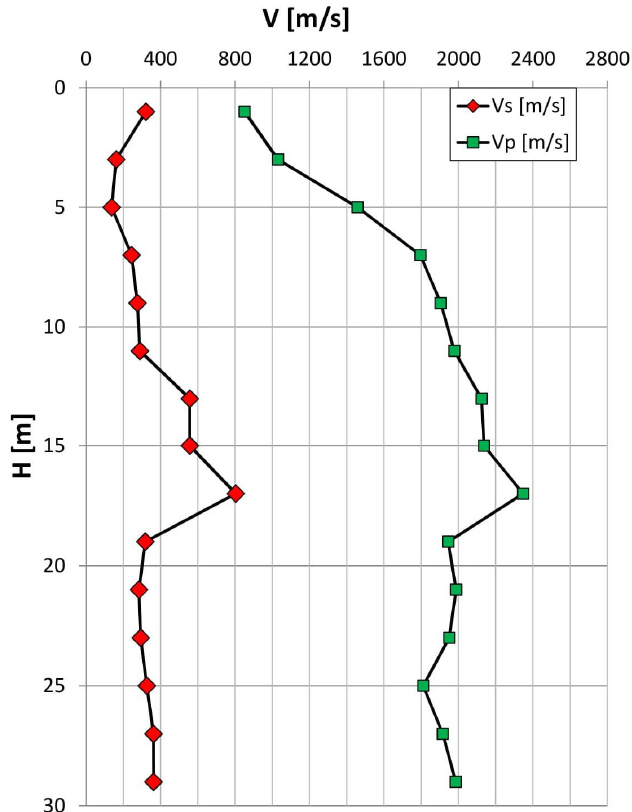
Figure 6. V s and V p from the Down Hole test (borehole S4).